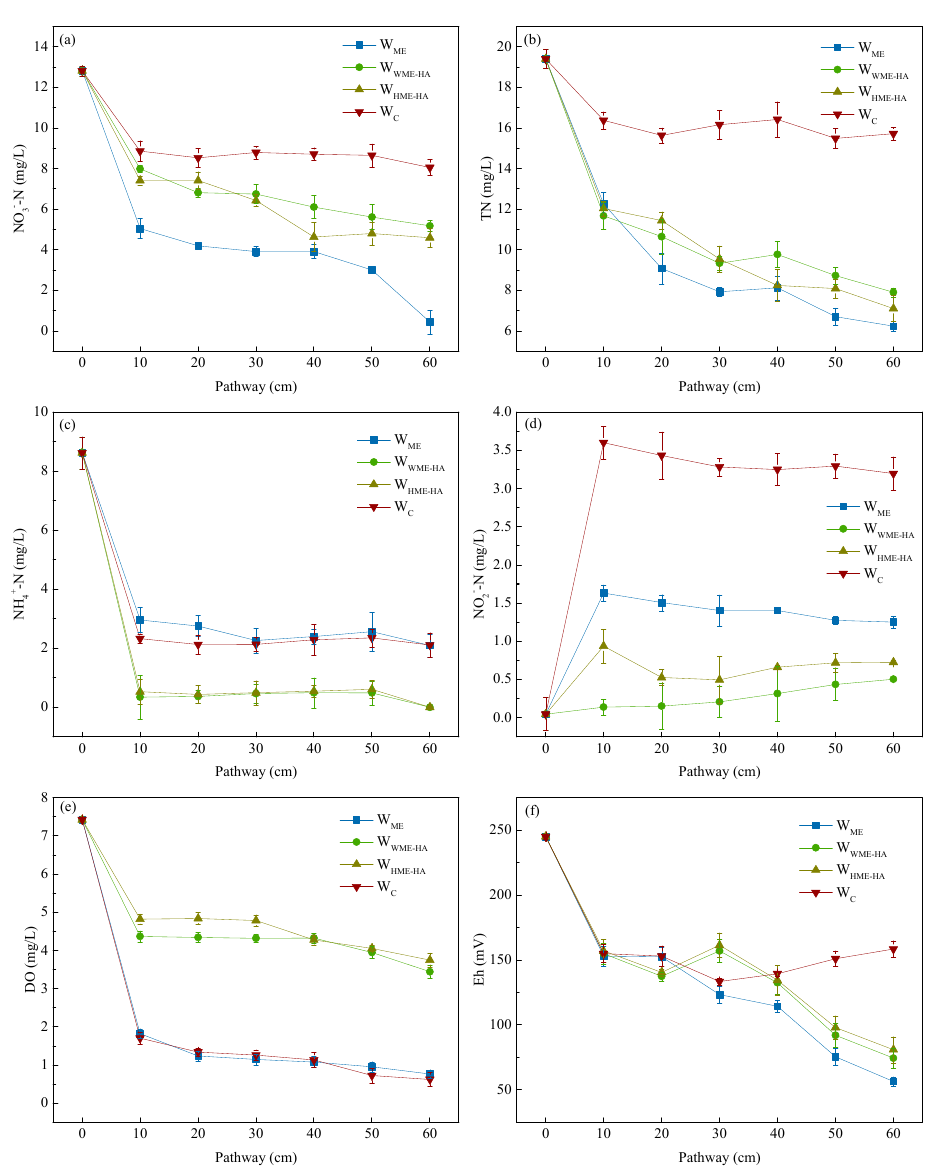
Figure 3. The NO 3 − -N ( a ), TN ( b ), NH 4 + -N ( c ), NO 2 − -N ( d ), DO ( e ), and Eh ( f ) concentration distributions in different heights of four subsurface flow constructed wetlands (SSFCWs).